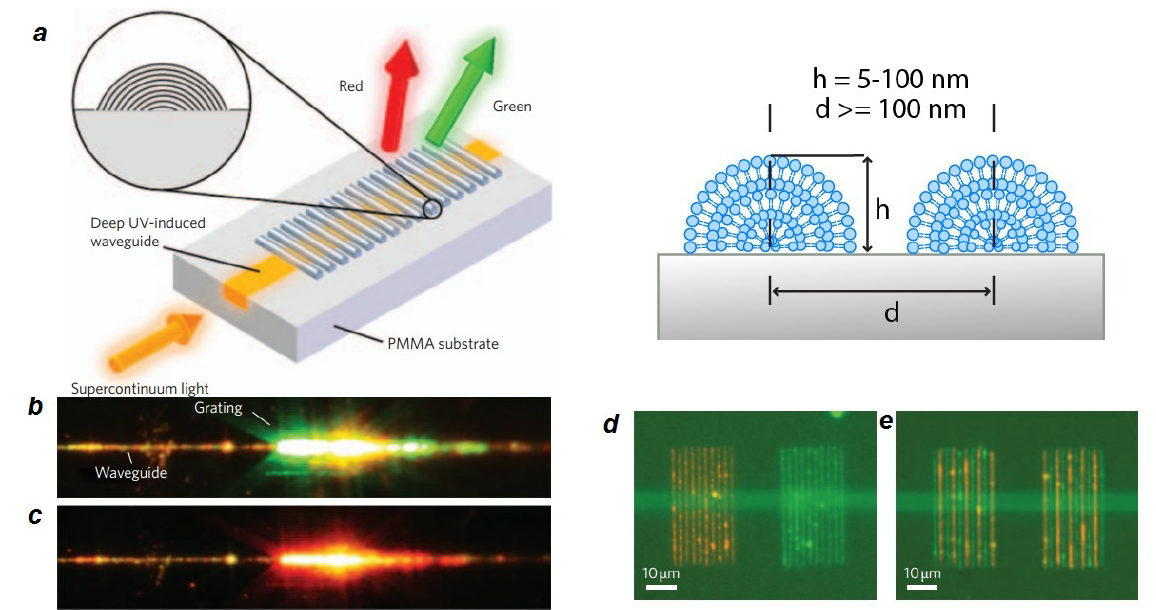
Figure 4. Lipid multilayer optical diffraction grating. ( a ) Schematic of the functional waveguide grating couplers. Light of a supercontinuum laser source is coupled into a single-mode strip waveguide through an optical fiber and decoupled under different angles by the grating coupler; ( b , c ) Photographs of the coupler at 308 and 458, where the red and green portions of the guided laser are coupled to radiation modes, respectively; ( d , e ) Fluorescence overlay of red and green fluorescence from rhodamine and fluorescein labelled lipids, respectively, integrated with a pitch (=2d) of 2 μ m by dip-pen nanolithography (DPN) patterning on a waveguide (horizontal green line is due to autofluorescence). Figure is adapted from [157] with